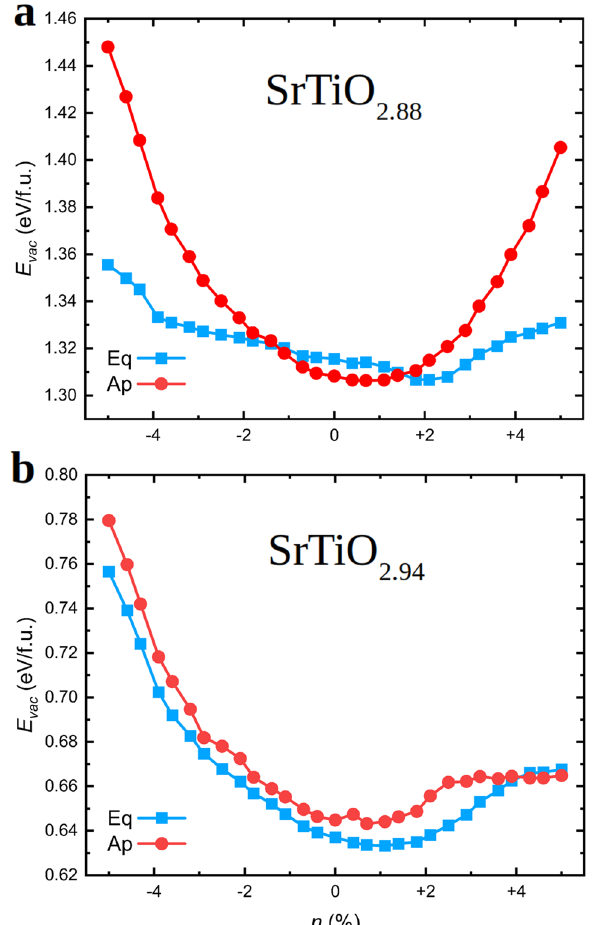
Figure 4. Zero-temperature formation energy of oxygen vacancies expressed as a function of oxygen position and epitaxial strain for compositions ( a ) SrTiO 2.88 and ( b ) SrTiO 2.94 . Labels “Eq” and “Ap” stand out for equatorial and apical V O , respectively. The solid lines are simply guides for the